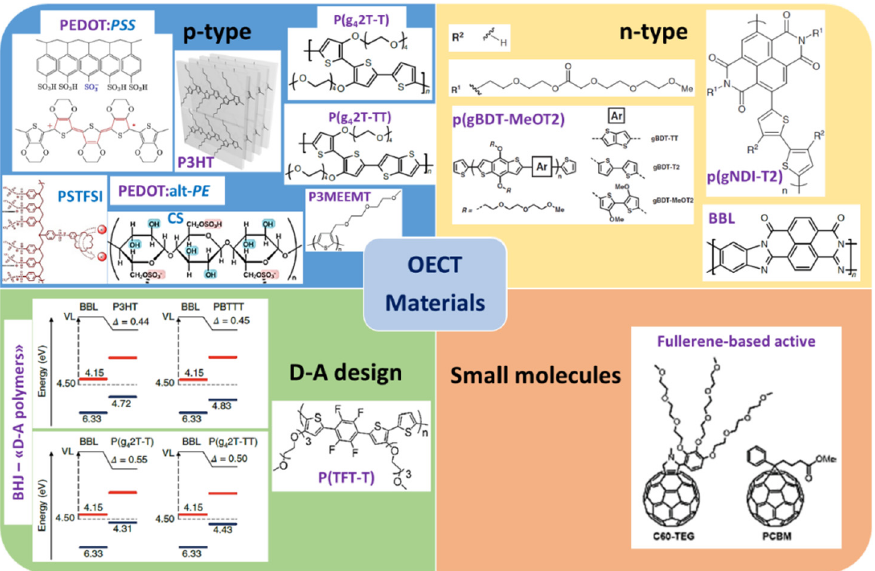
Figure 6. Summary of representative OECT materials. Chemical structures of: p-type materials such as PEDOT derivatives including the most used material PEDOT:PSS [30,31,33,38,51,59,64,66] and other thiophene derivatives [32,37,70,71,78,80]; n-type materials based on thiophene-based building block modifications or ladder polymers [87–91]. Donor–acceptor (D–A) strategy such as integration of rigidizer fluoroaromatic rings or heterojunctions based on the combination of D–A polymers [84,85]. Small molecules as active channel materials [94]. (With permission from John Wiley and Sons, American Chemical Society, and Springer Nature).